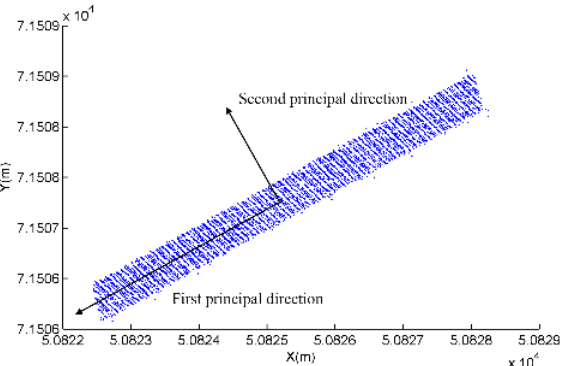
Figure 11. Principal component analysis of road markings.